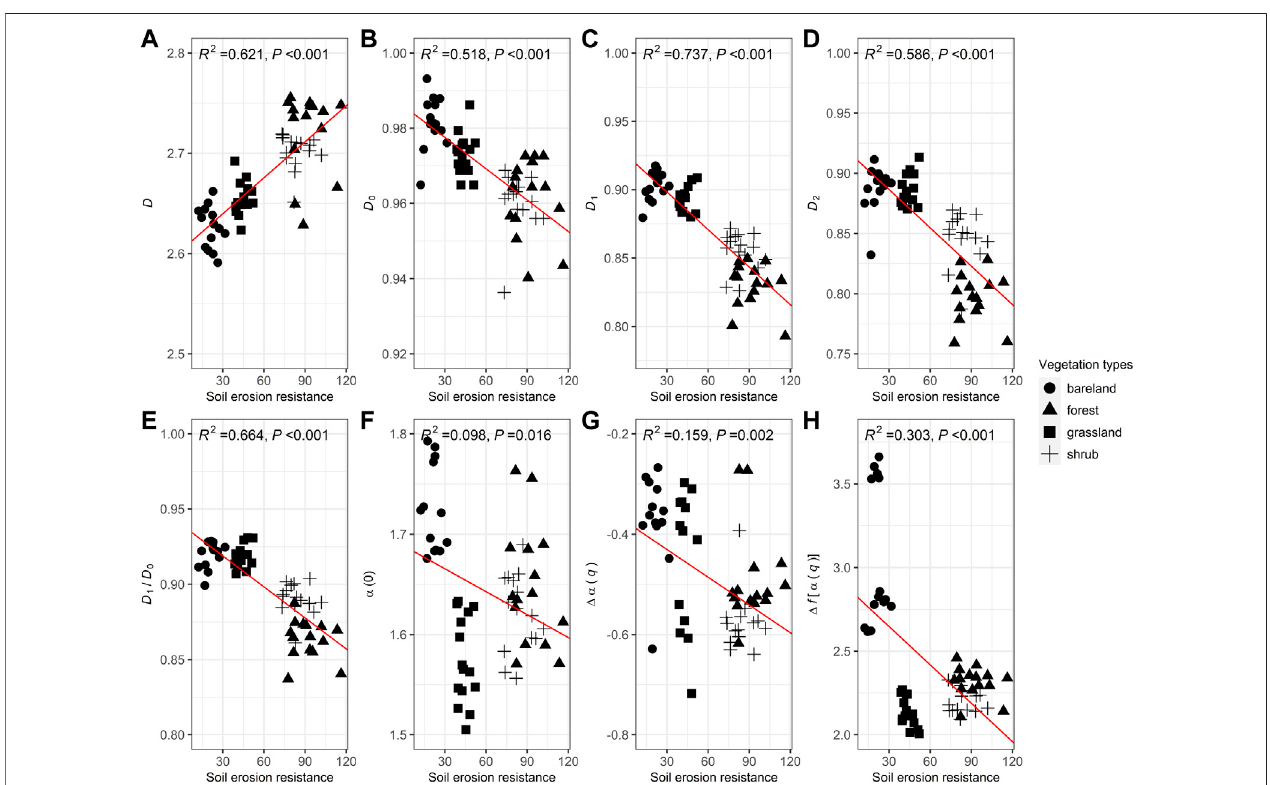
FIGURE6| Relationshipsbetweensoilerosionresistanceandmultifractalparametersincluding D (A) , D 0 (B) , D 1 (C) , D 2 (D) , D 1 / D 0 (E) , α (0) (F) , Δ α ( q ) (G) , Δ f [ α ( q )] (H) .